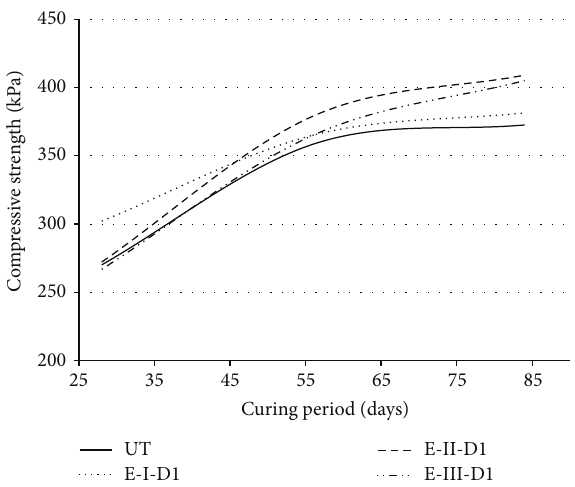
Figure 5: Variations in UCS for untreated (UT) and treated (single dosage) soil samples.